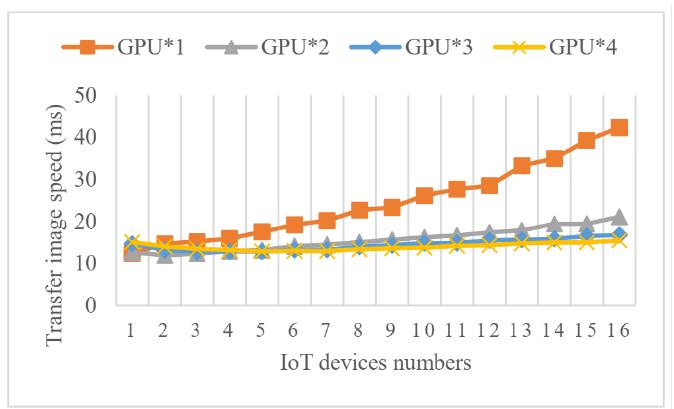
Figure 11. Image prediction time on